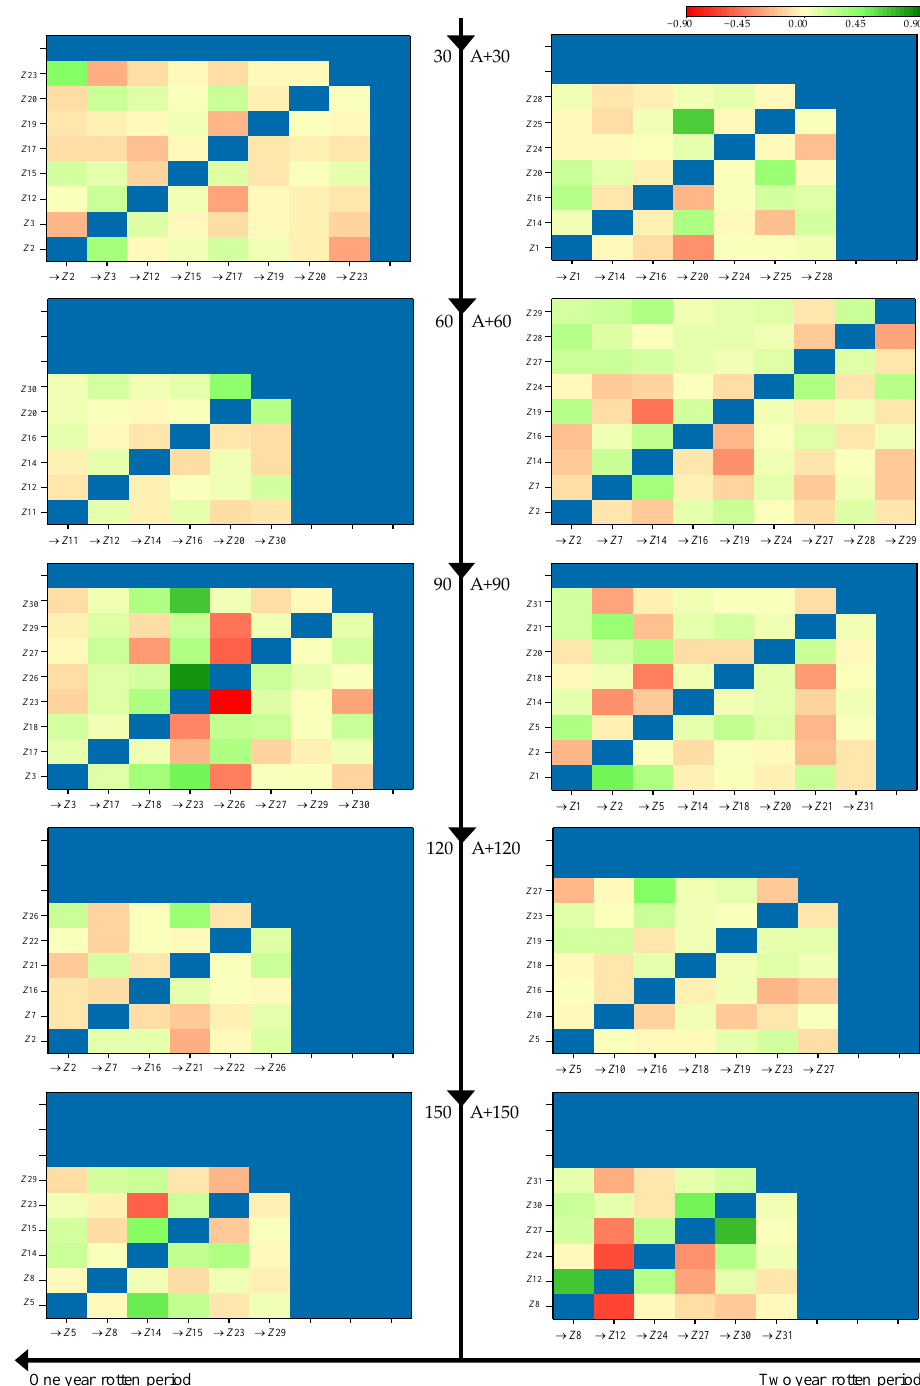
Figure 2. Indirect path effect between carbon sources. (A, year; Z0, water; Z1, β − methyl − D − glucoside; Z2, D − galactonic acid γ − lactone; Z3, L − arginine; Z4, pyruvic acid methyl ester; Z5, D − xylose; Z6, D − galacturonic acid; Z7, L − asparagine; Z8, tween 40; Z9, I − erythritol; Z10, 2 − hydroxy ben- zoic acid; Z11, L − phenylalanine; Z12, tween 80; Z13, D − mannitol; Z14, 4 − hydroxy benzoic acid; Z15, L − serine; Z16, α − cyclodextrin; Z17, N − acetyl − D − glucosamine; Z18, γ − hydroxybutyric acid; Z19, L − threonine; Z20, glycogen; Z21, D − glucosaminic acid; Z22, itaconic acid; Z23, glycyl − L − glutamic acid; Z24, D − cellobiose; Z25, glucose − 1 − phosphate; Z26, α − ketobutyric acid; Z27, phenylethyl − amine; Z28, α − D − lactose; Z29, D , L − α − glycerol phosphate; Z30, D − malic acid; Z31,